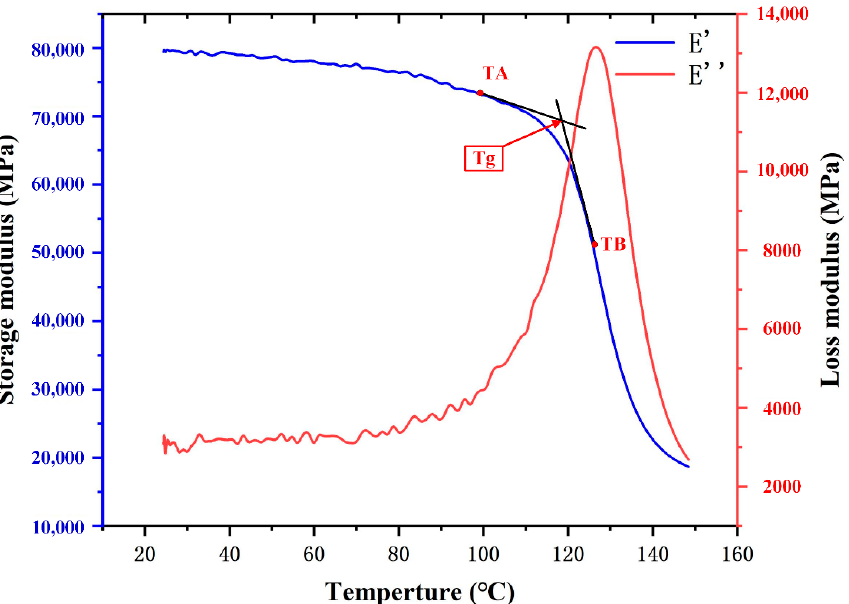
Figure 3. Representative curves of the loss modulus (right axis) and storage modulus (left axis) versus temperature for CFRP laminates measured by the dynamic mechanical analysis (DMA) test.